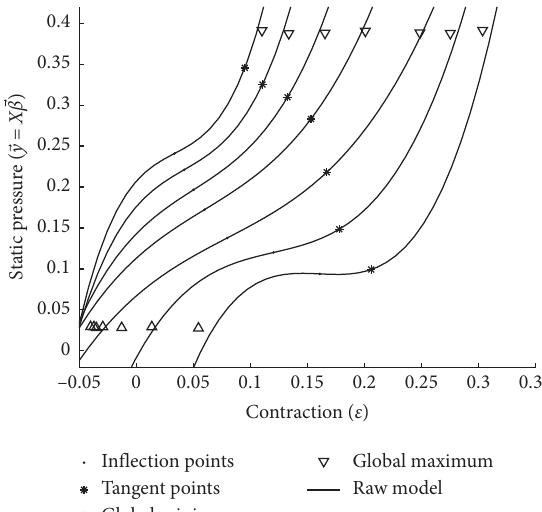
Figure 6: Unoptimized static pressure model using polynomial parameterization of third